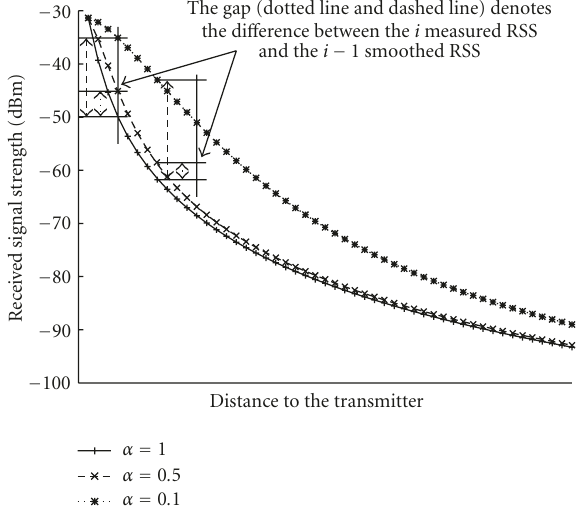
Figure 4: E ff ect of smoothing factor α